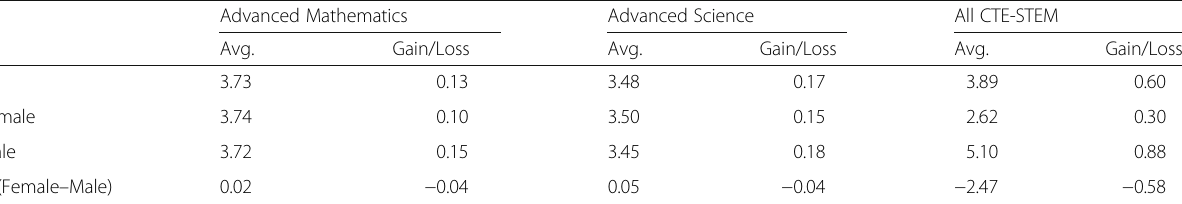
Table 7 Six-year average enrollment rates and gain/loss of enrollment by gender in advanced mathematics, advanced science, and all CTE-STEM